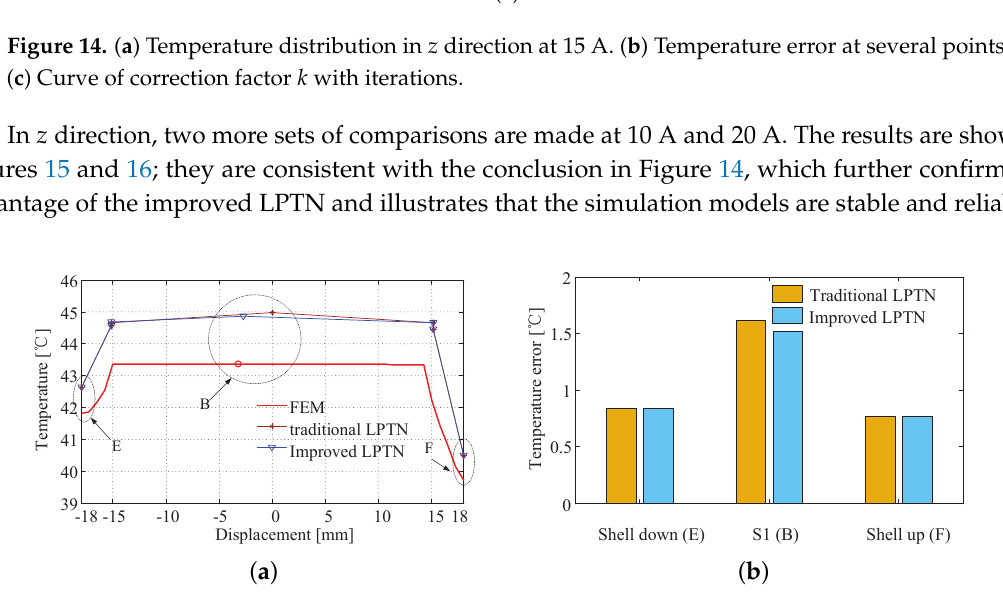
Figure 15. ( a ) Temperature distribution in z direction at 10 A. ( b ) Temperature error at several